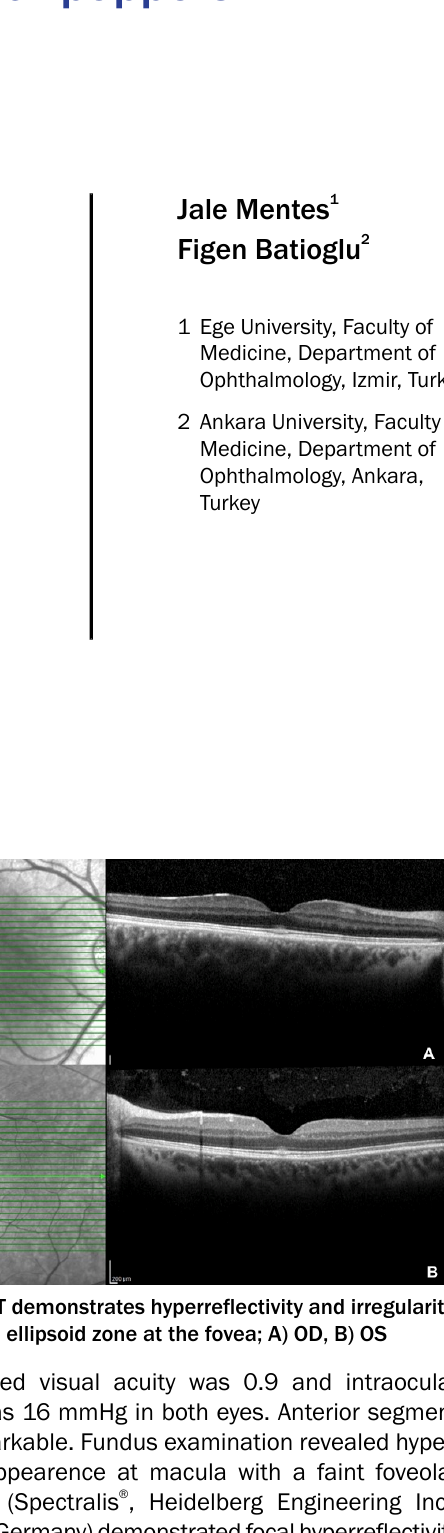
Figen Batioglu 2